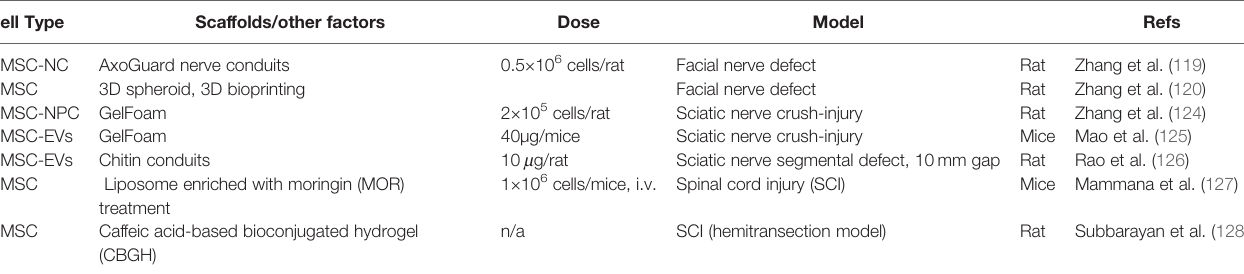
TABLE 6 | GMSC-based regenerative therapy for nerve